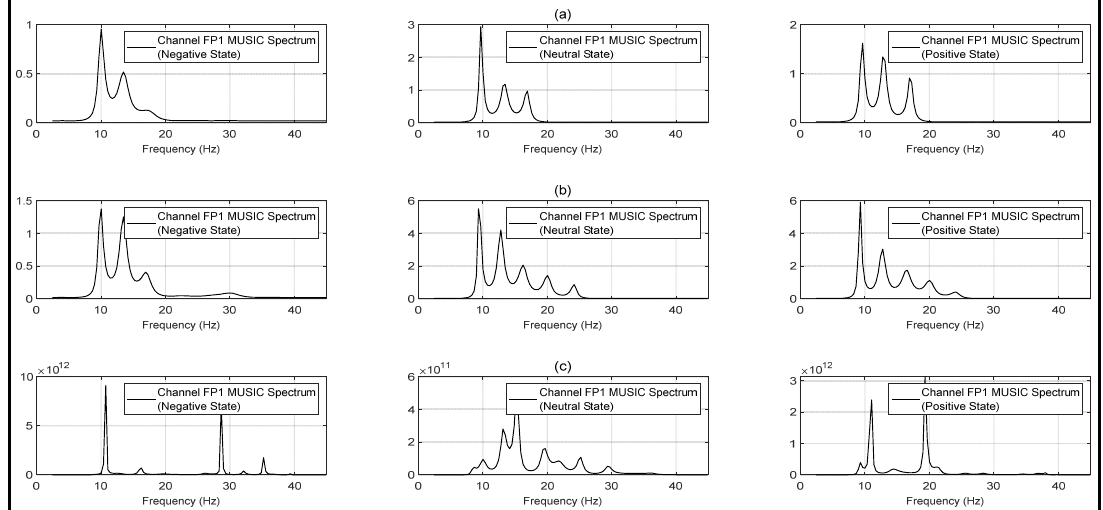
Figure 4. MUSIC-transformed power-spectrum density spectrum with varying signal subspace es- timation for subject: 15, state: negative, trial: 10, channel: FP1 ( a ) considering δ , θ , α , β and γ bands as signal subspace vector ( b ) considering α , β and γ bands as signal subspace vector ( c ) undefined signal subspace vector.